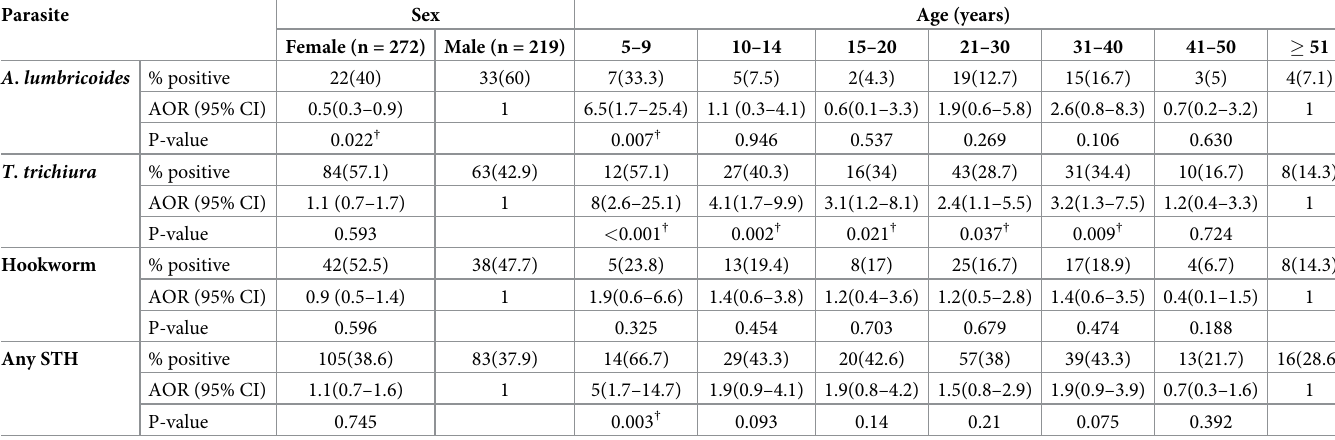
Table 3. Prevalence of species-specific STH infection by sex and age in Yeki district of southwest Ethiopia (2017). Parasite